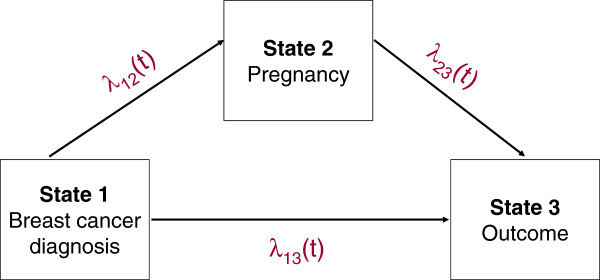
“Illness-death” model. “Illness-death” model with three transition intensities λuv(t).